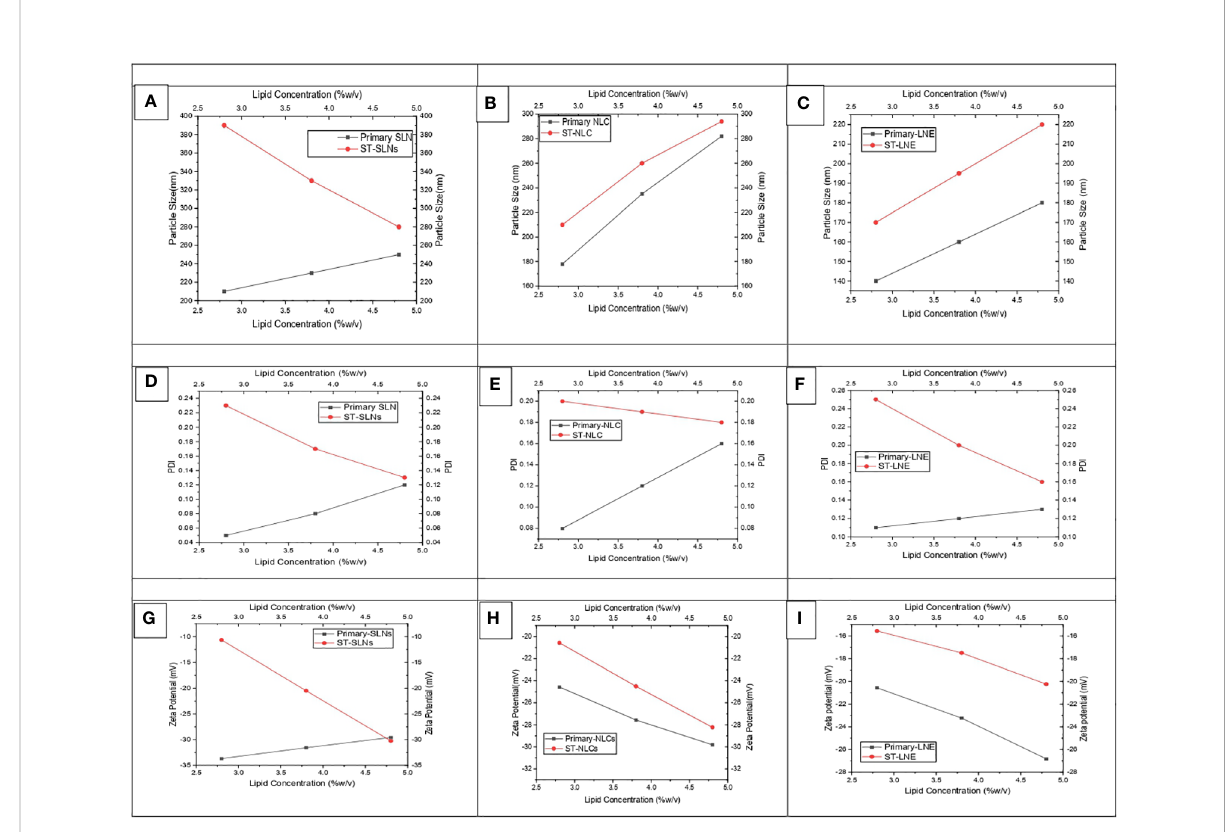
FIGURE 1 (A-C) particle size, (D-F) PDI, and (G-I) zeta potential values of prepared both drug-free and drug-loaded SLN, NLC, and